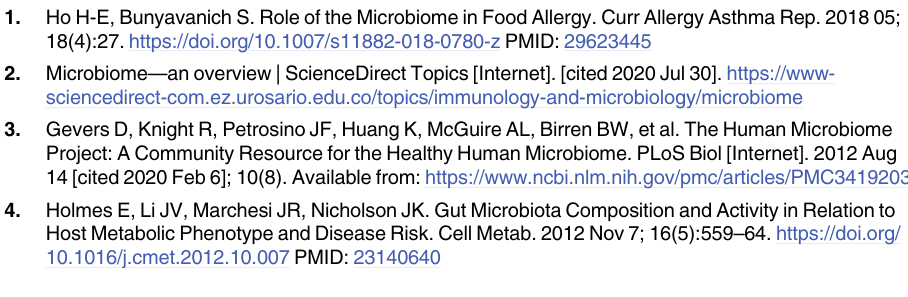
S1 Table. ROBINS-I risk of bias assessment summary: Review authors’ judgements about each methodological quality item for each included study in this